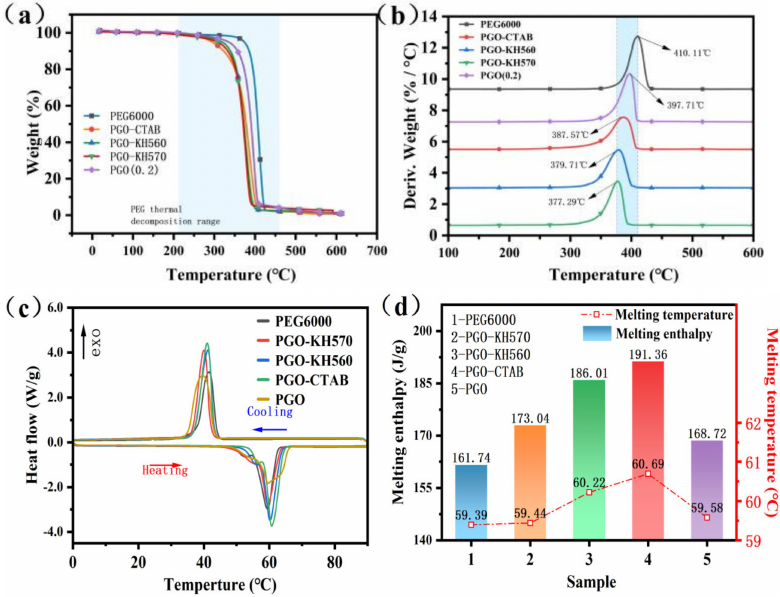
Figure 4. ( a ) TGA, ( b ) DTG, ( c ) DSC curves, ( d ) phase transition enthalpy and temperature of PEG6000 and GO-PEG